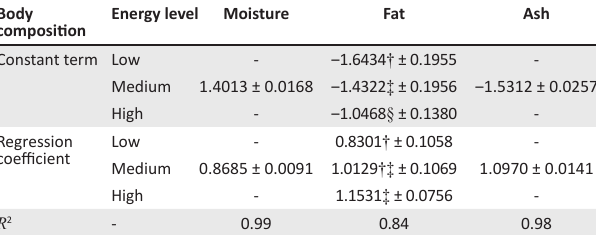
TABLE 6: Allometric coefficients relating the natural logarithms of the chemical component growth (kg) in the whole body (as is) to the natural logarithms of empty body protein weight (kg) with dietary energy levels as groups.